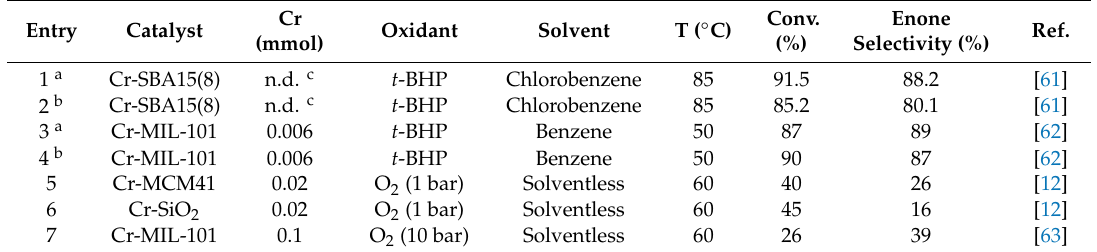
Table 16. Chromium-containing solid materials for allylic oxidation of α -pinene 1 .